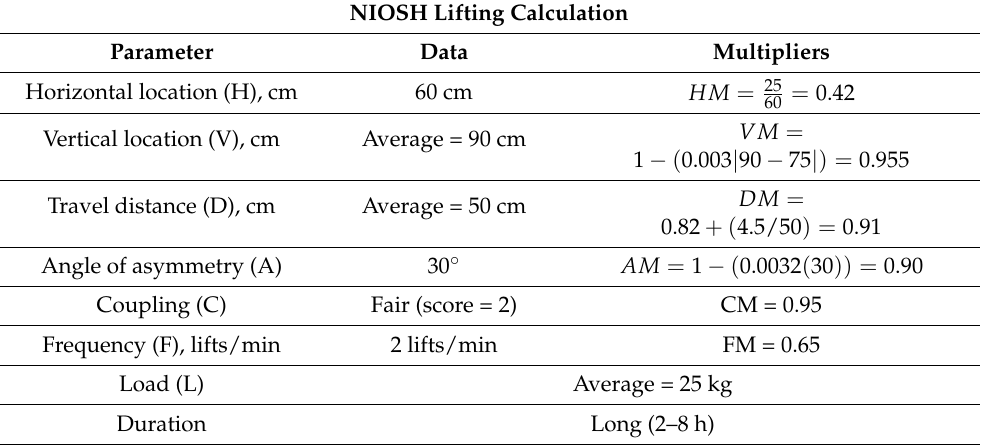
NIOSH Lifting Calculation